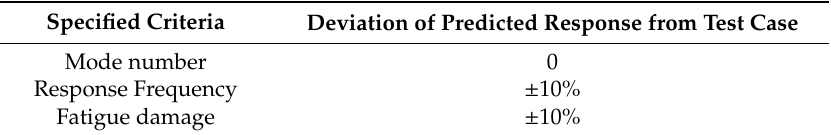
Table 3. Specified criteria for selecting the optimal set of parameters.